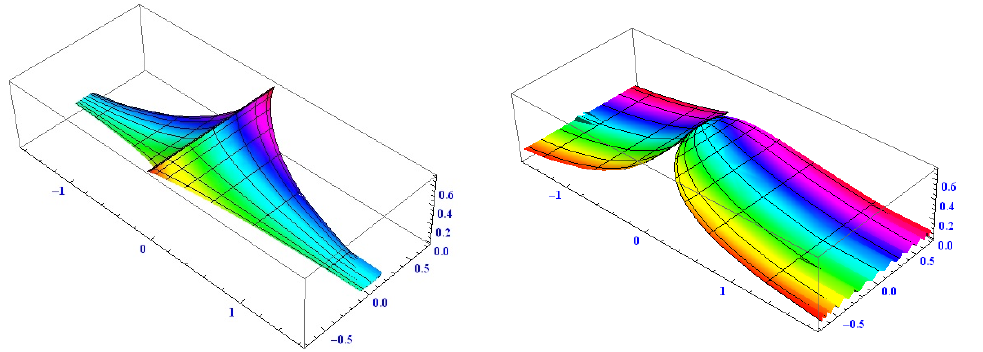
Figure 2. Projections of R ( u , v , w ) into ( Left ) x 1 x 3 x 4 space, ( Right ) x 2 x 3 x 4 space.